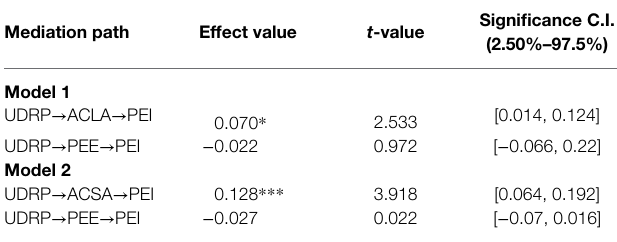
TABLE 5 | Mediation effect analysis. Mediation